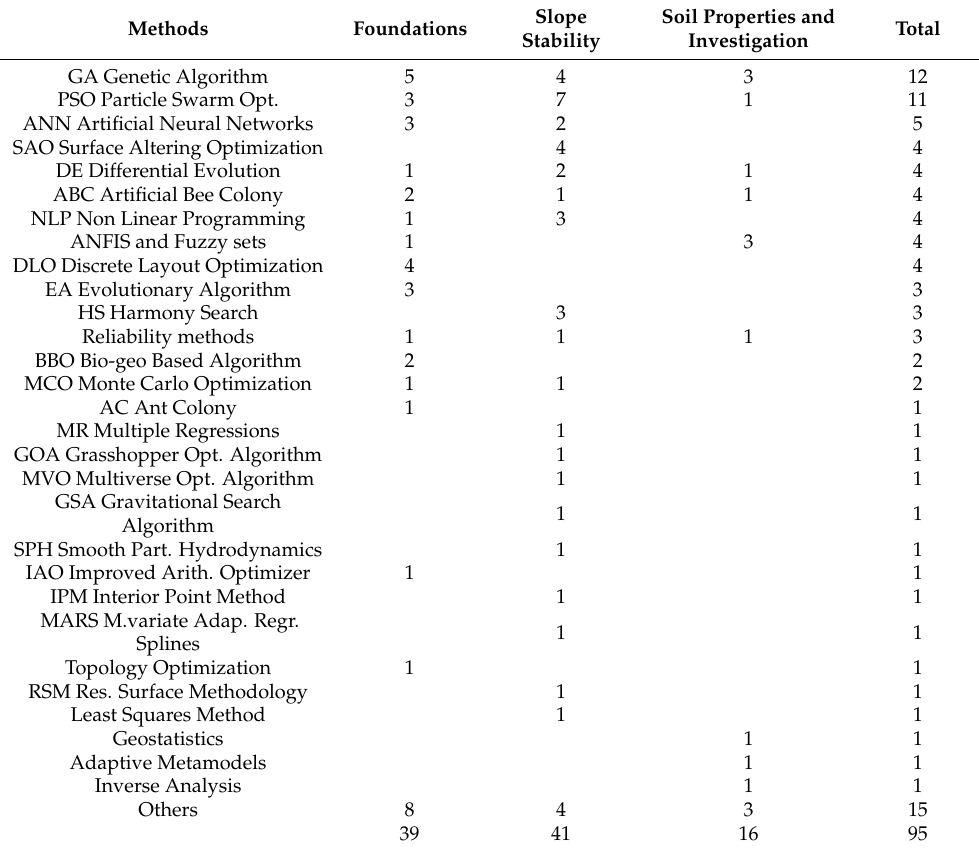
Table 1. Occurrence of different optimization